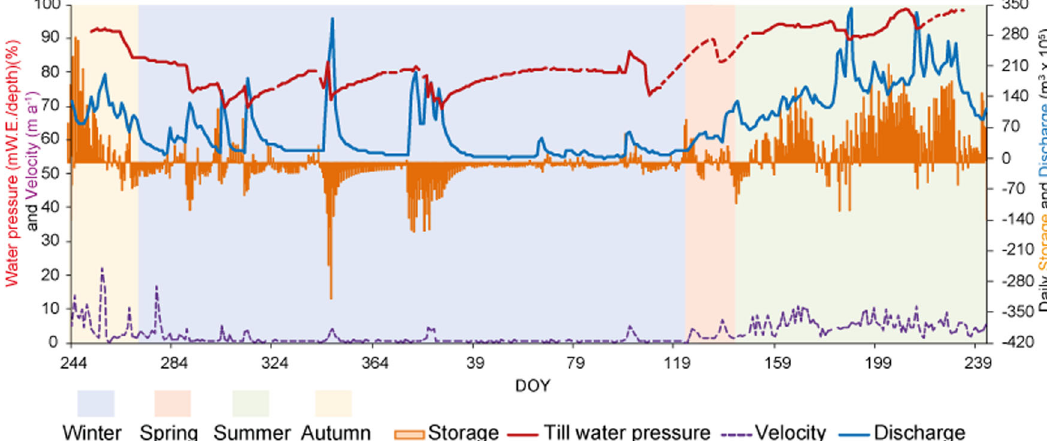
Fig. 7 Summary annual record. Skálafellsjökull composite storage (melt and rain minus discharge), till water pressure, and discharge from 2009/2010 data, velocity data estimated based on data from other